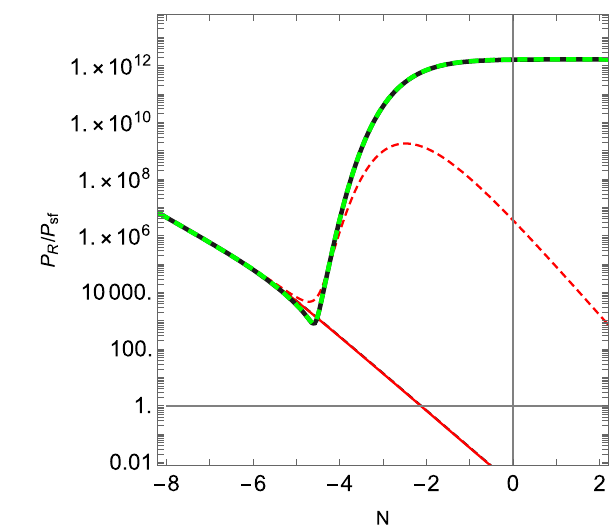
Fig. 5 Numerical calculations in single-field effective theories for hyperinflation; model described in Sect. 5.3. Left panel: evolution of the sound speed given by Eq. (6) for initial conditions leading to a freezing adiabatic mode (red solid line) and for initial conditions lead- ing to a decaying adiabatic mode (blue dashed lines); change of sign of